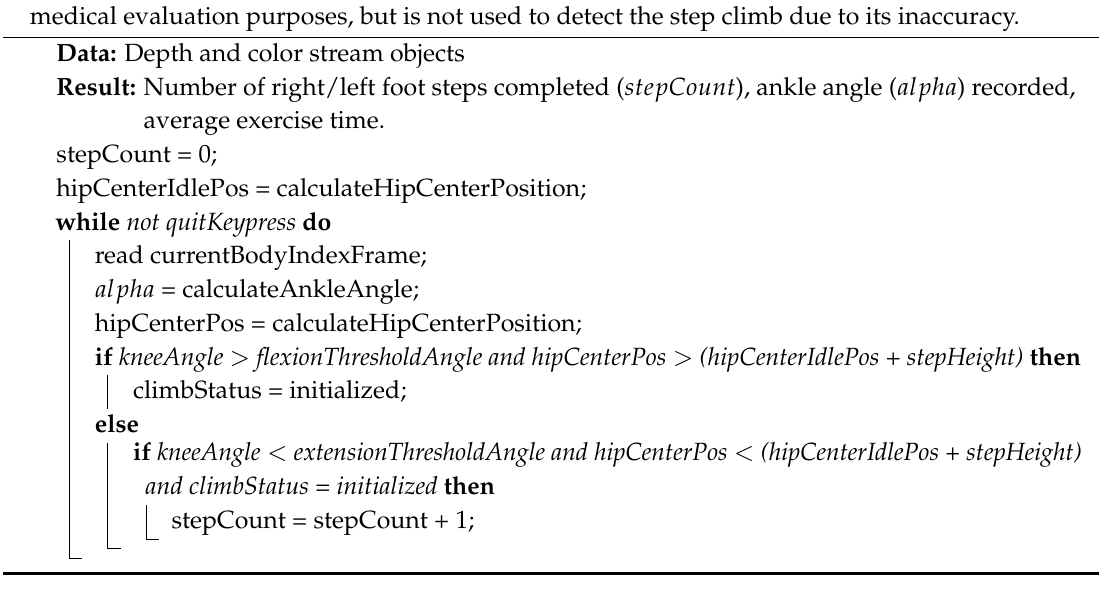
Algorithm 3: Balance exercise algorithm. Balance is evaluated in 8 directions in the XZ plane, targeted sequentially in clockwise order: north (N), northeast (NE), east (E), southeast (SE), south (S), southwest (SW), west (W) and northwest (NW), where N corresponds to the player’s front-facing direction. The player must swing back to the starting position ( idlePos ) before each change of direction. The scores’ array contains the percentages of time spent by the subject in each of the target balance